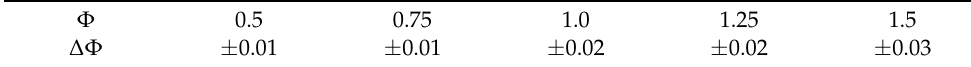
Table 2. The uncertainty of the equivalence ratio of the prepared